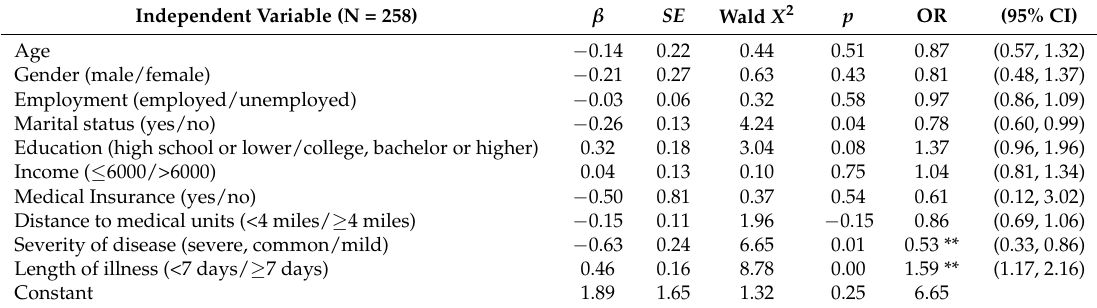
Table 5. Multivariable logistic regression analyses on influencing factors of self-medication. Independent Variable (N = 258)